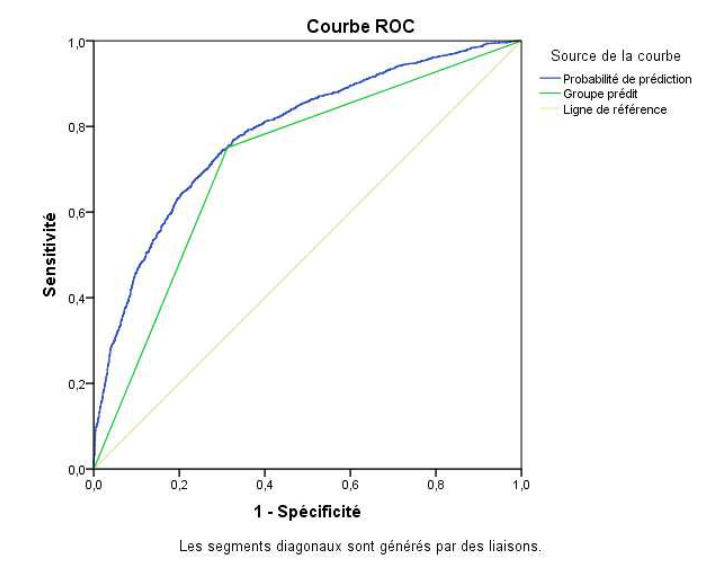
Figure B1. Performance of the LR model (ROC)